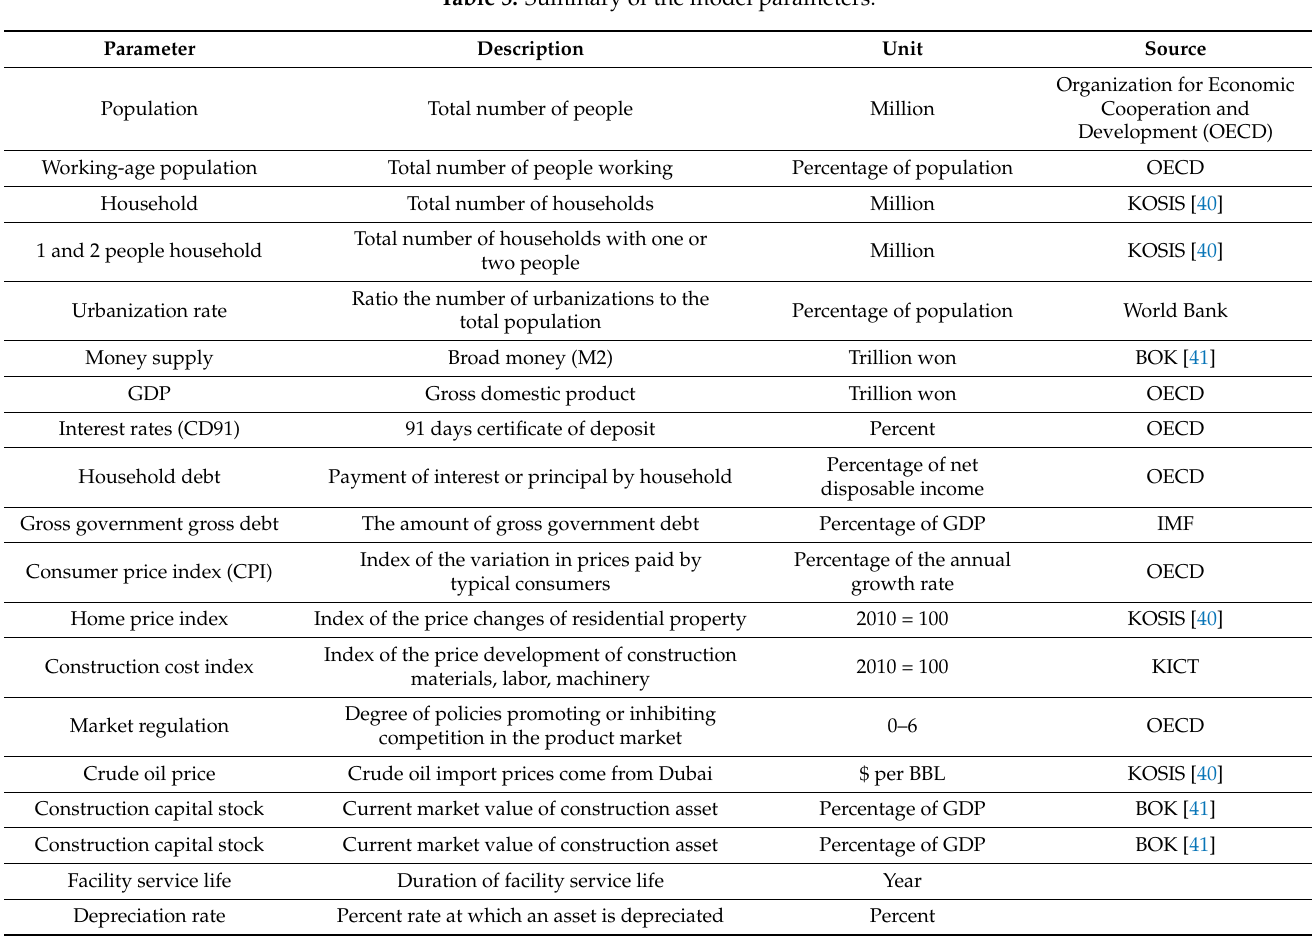
Table 5. Summary of the model